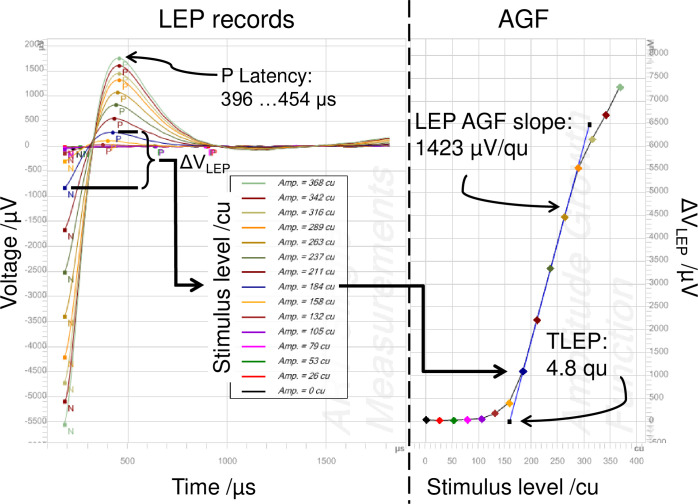
Example of a LEP measurement with clear responses.P peaks are well pronounced and the AGF appears unambiguous and steep with a broad linear region. Subject A-10, PD = 30 μs, stimulating electrode E05, recording electrode E04. TLEP = 159 cu corresponding to 4.8 qu, LEP slope = 42.68 μV/cu corresponding to 1422.83 μV/qu. Latencies of P peaks are between 396 and 454 μs after stimulus onset. See S1 Fig for raw responses.